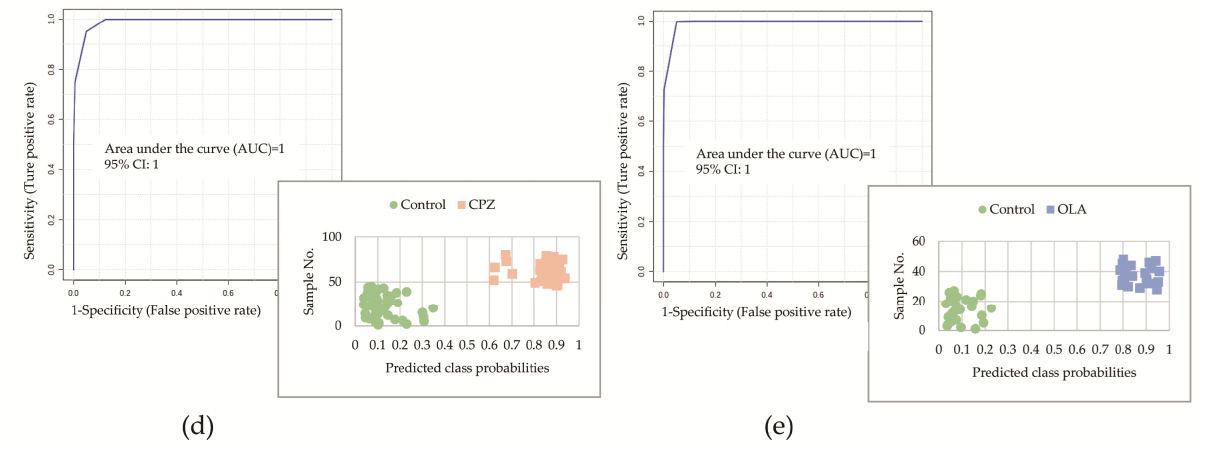
Figure 7. Time-dependent changes in levels of L-acetylcarnitine ( a ), propionylcarnitine ( b ), and succinic acid ( c ) at 4 °C for ≤ 10 days treated by OLA or CPZ (n animal = 7) at a high dose compared with controls (n animal = 9). Values are expressed as the mean. ( d ) The AUC for prediction performance of fatal intoxication due to CPZ was 1 (95%CI of AUC: 1–1) on day 0. Predicted class probabilities of stored samples within 10 days (bottom right) showed zero misclassifications based on the DCM (Nsample = 7 + 9 on days 2, 4, 6, 8, and 10, respectively). ( e ) The AUC for prediction performance of fatal intoxication due to OLA was 1 (95%CI of AUC: 1–1) on day 0. Predicted class probabilities of stored samples within 6 days (bottom right) showed zero misclassifications based on the DCM (Nsample = 7 + 9 on days 2, 4, and 6). Abbreviations: LCP: lethal poisoning by CPZ at a high dose; LOP: lethal poisoning by CPZ at a high